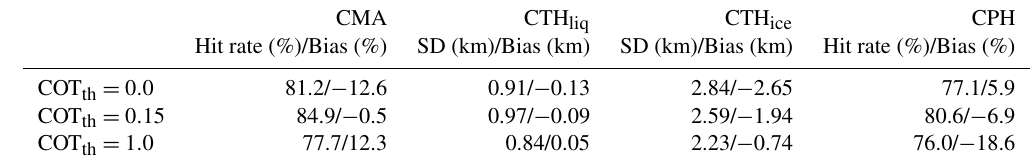
Table 1. Global validation scores of Cloud_cci AVHRR-PM v2.0 cloud mask (CMA), cloud-top height (CTH) and cloud phase (CPH) against CALIOP. For CMA the validation scores are shown as a function of a COT threshold (COT th ), which is used for separating cloudy from clear-sky CALIOP pixels. For CTH and CPH the scores are also shown as a function of (COT th ), although (COT th ) is here referring to the optical thickness into the cloud (top-down) at which the reference value was taken from the CALIOP profile (SD = Standard deviation). CMA CTH liq CTH ice CPH Hit rate (%)/Bias (%) SD (km)/Bias (km) SD (km)/Bias (km) Hit rate (%)/Bias (%) COT th = 0 . 0 81.2/ − 12.6 0.91/ − 0.13 2.84/ − 2.65 77.1/5.9 COT th = 0 . 15 84.9/ − 0.5 0.97/ − 0.09 2.59/ − 1.94 80.6/ − 6.9 COT th = 1 . 0